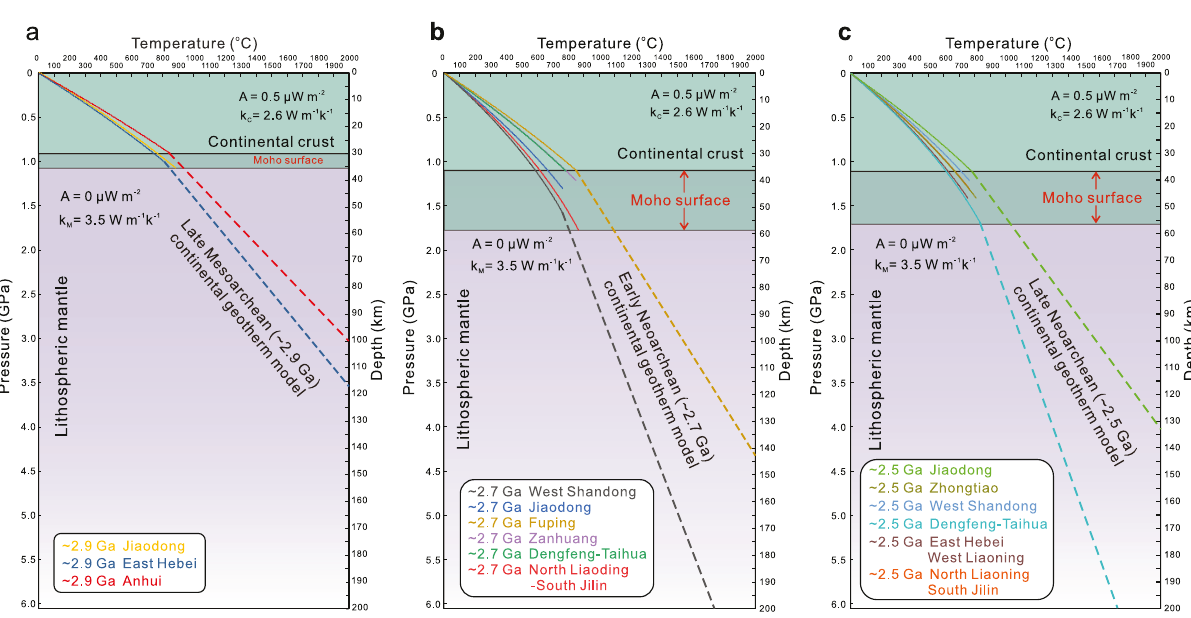
Fig. 4 Generic model for the Meso- to Neoarchean thermal evolution of the North China Craton. a Late Mesoarchean (~2.9 Ga) continental geothermal model; b early Neoarchean (~2.7 Ga) continental geothermal model; c late Neoarchean (~2.5 Ga) continental geothermal model. In these models, the Archean continental geotherm was constrained assuming a steady-state conductive geotherm, without considering the effects of heat convection of the asthenosphere mantle. The depth of Moho surface is determined by melting pressure of crustal-derived TTG melts, whereas the Archean lithospheric thickness is